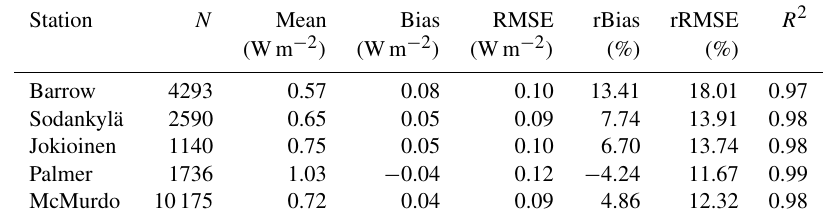
Table 6. Statistical indicators of the performances of the method for UV-B irradiance. N is the number of data points.